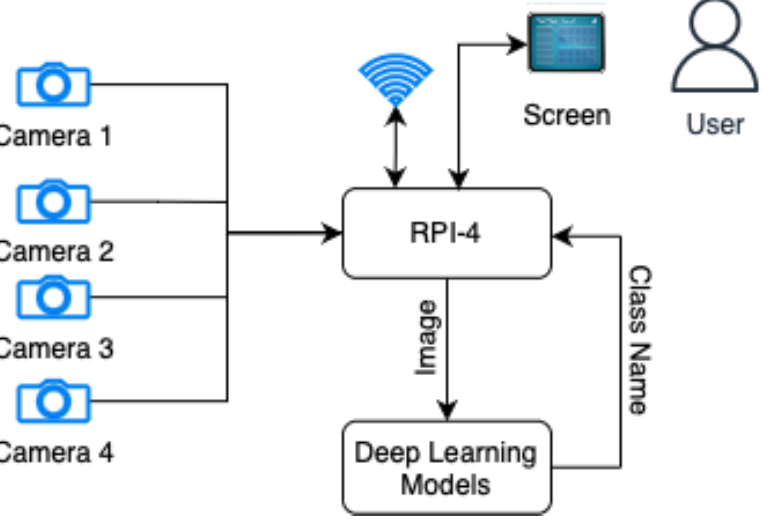
Figure 1. Description of the